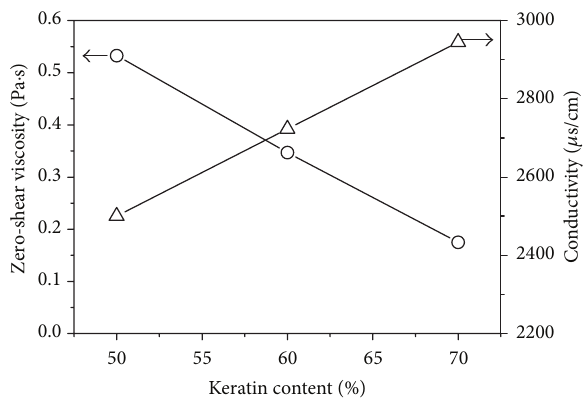
Figure 2: Zero-shear viscosity and conductivity of the keratin/PVA blend solutions as a function of keratin